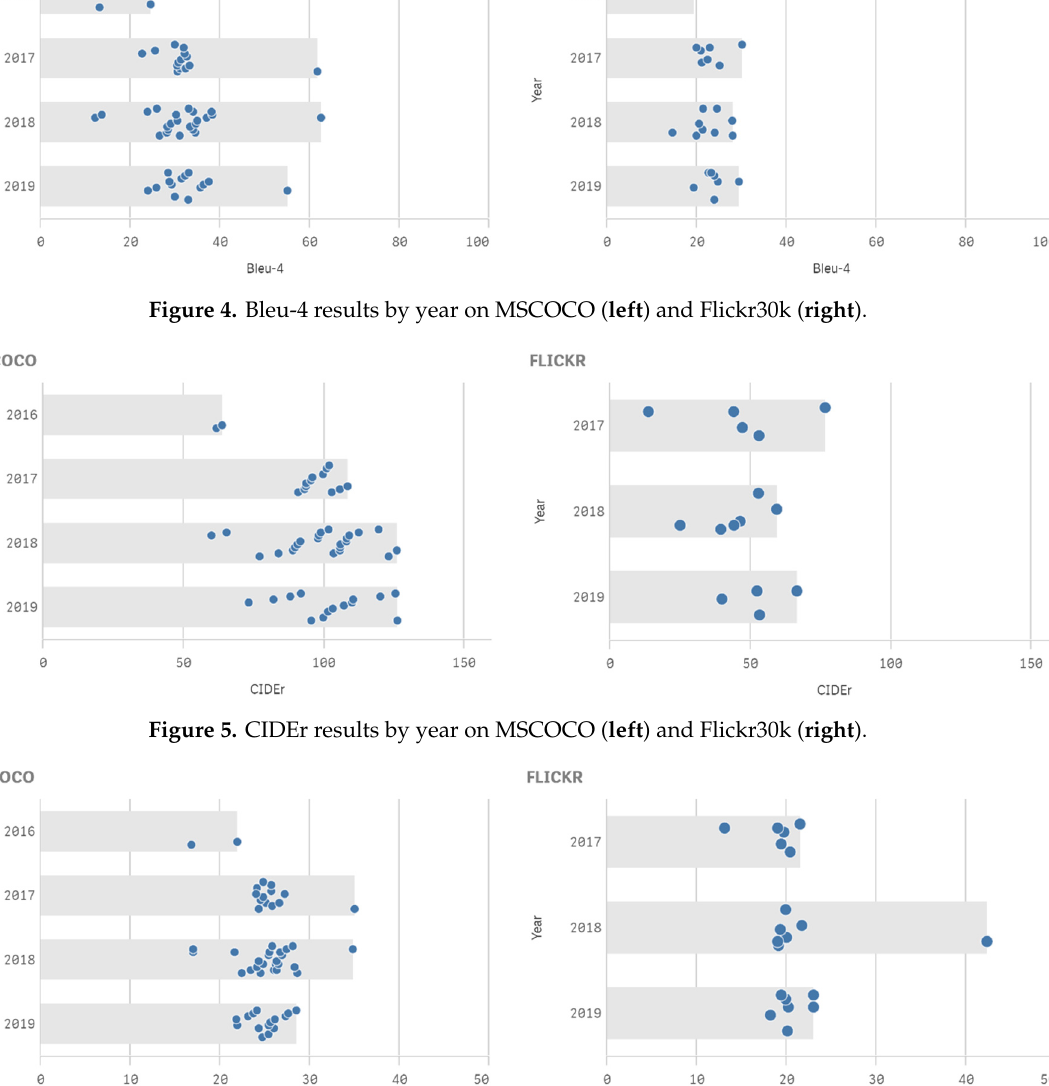
Figure 3. Bleu-3 results by year on MSCOCO ( left ) and Flickr30k ( right ).